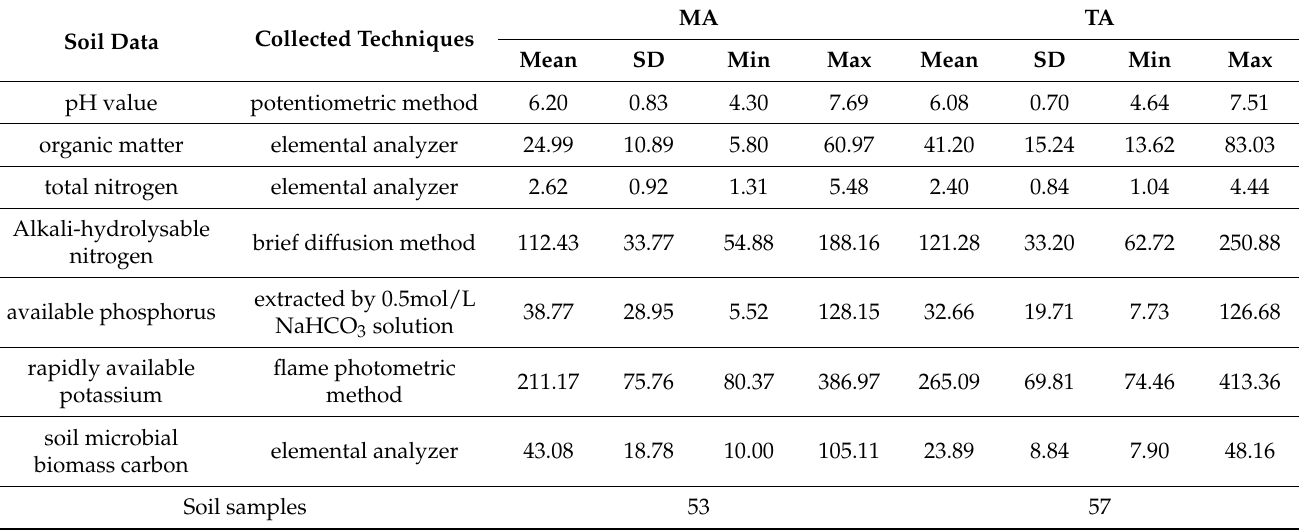
Table 2. Descriptive statistics of the soil data in MA and TA.